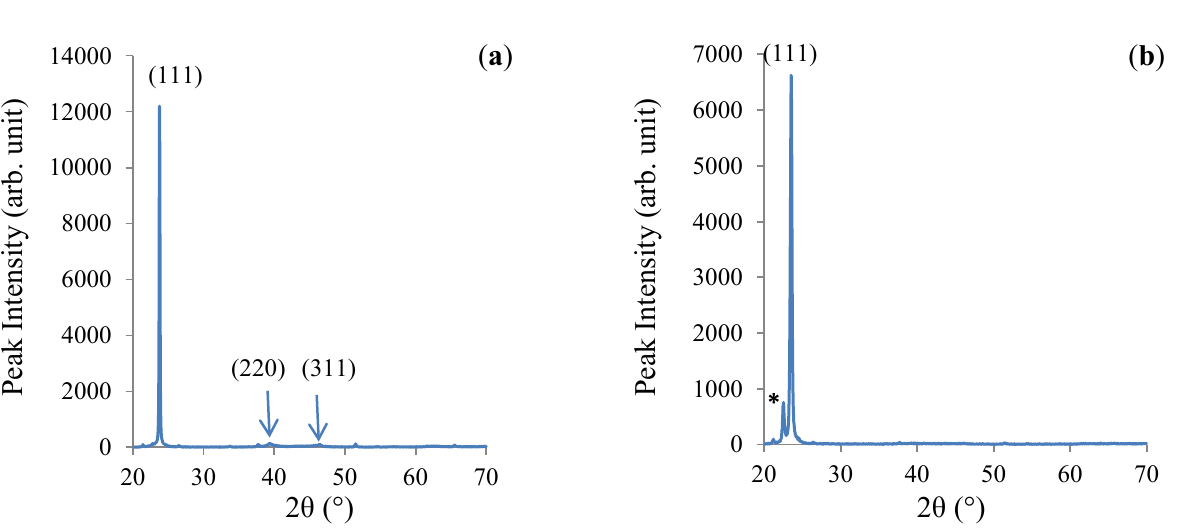
Figure 2. X-ray diffraction (XRD) patterns of ( a ) as-deposited CdTe (AD-CdTe) layer on glass/FTO; and ( b ) as-deposited CdTe layer on glass/FTO/CdS substrate. All other low-intensity peaks arise from the fluorine doped tin oxide (FTO) substrate. The peak marked with “*” represent either TeO or Cd TeO . The peak parameters are more 2 3 6 appropriate to Cd TeO reference 3 6